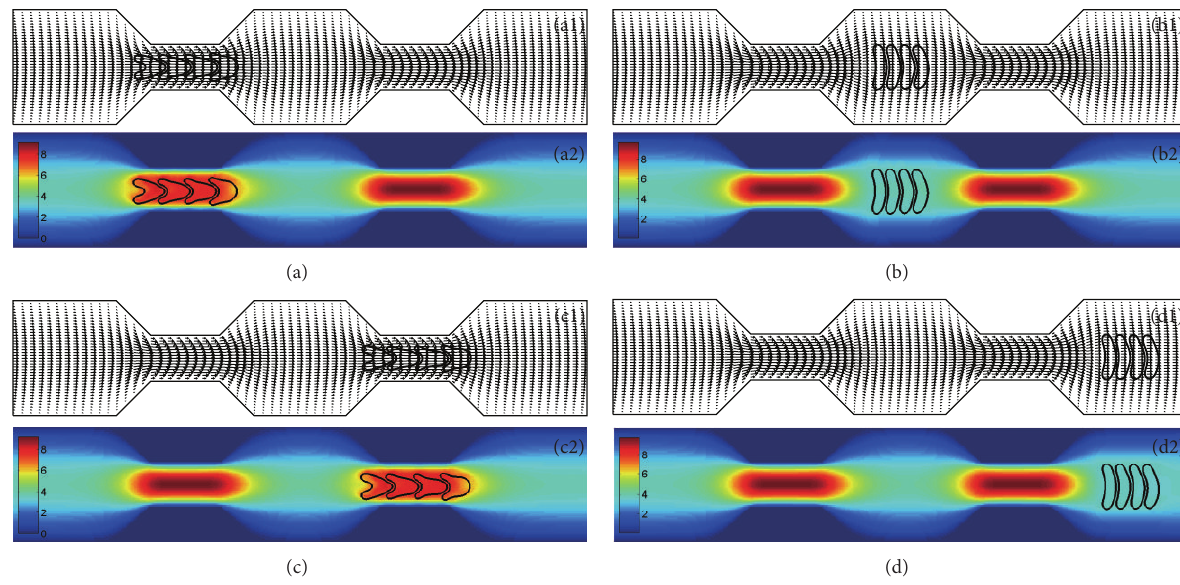
Figure 11: Motion and dissociation of a four-cell erythrocyte aggregate which is vertically placed in a 8 𝜇 m stenotic channel at time instants (a) 𝑡 = 0.47 ms; (b) 𝑡 = 0.86 ms; (c) 𝑡 = 1.25 ms; and (d) 𝑡 = 1.64 ms. Velocity vectors (a1-d1) and axial velocity magnitude contours (cm/s) (a2-d2) are presented. The initial configuration for the aggregate is shown in Figure 1(f), and the aggregate is vertically placed in the channel initially. The parameters used are 𝐷 𝑒 = 1.0 𝜇 J/m 2 , 𝑘 𝑏 = 3.0 × 10 −12 Nm.